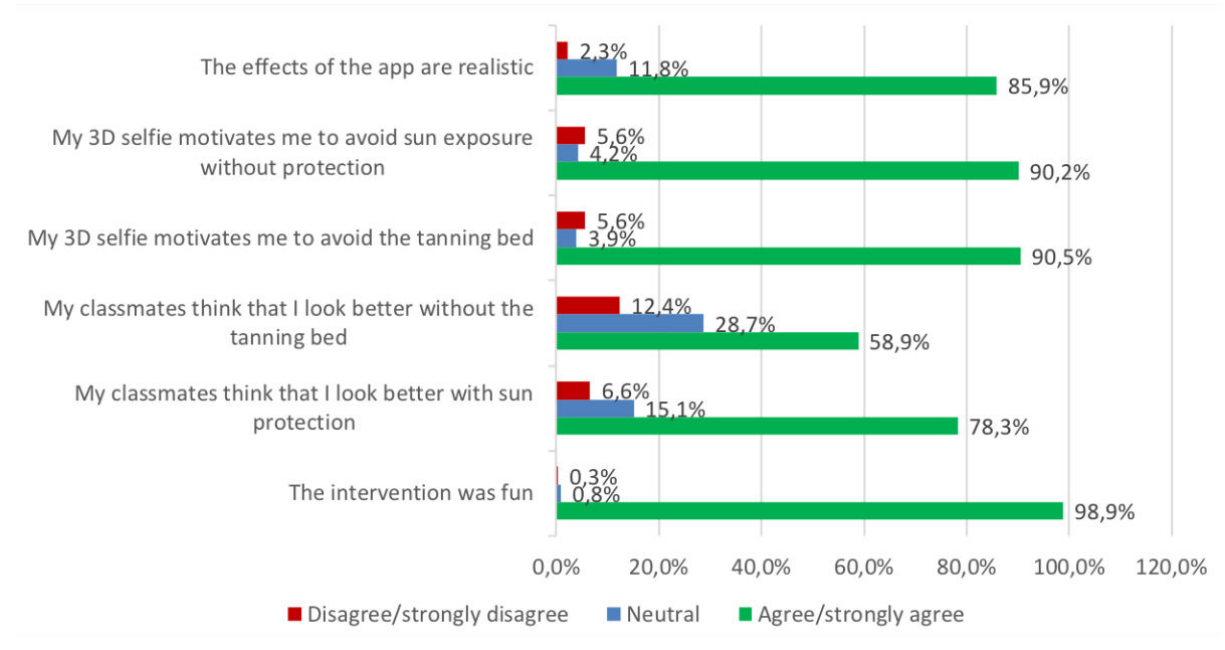
Figure 7. Overall results of the whole sample. 3D: 3-dimensional.